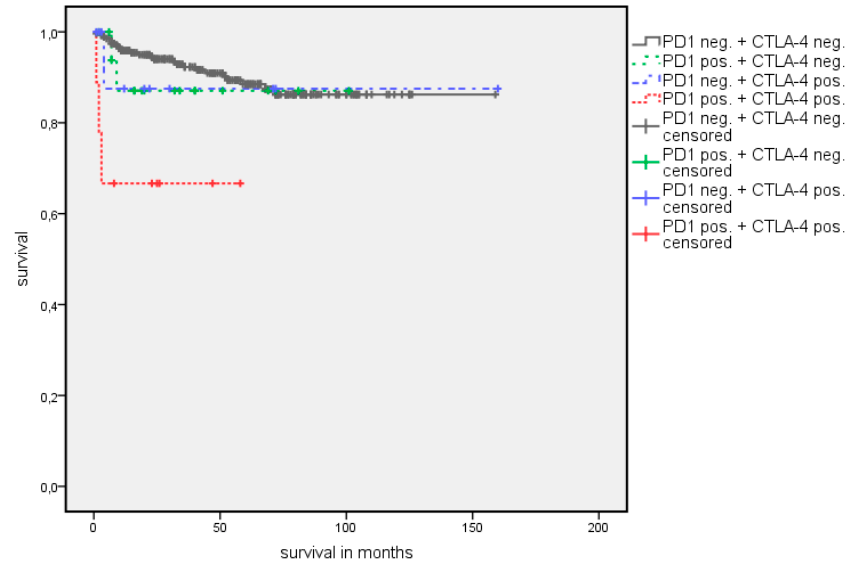
with OS in all RCC patients.